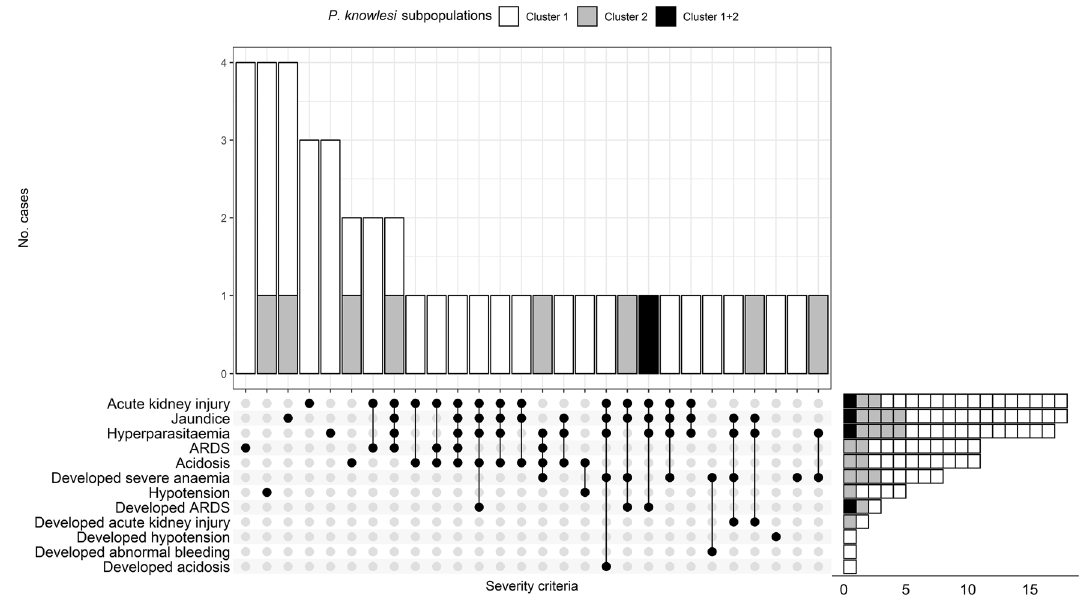
Figure 2. Combinations of severe criteria among patients infected with P. knowlesi subpopulations (N = 44). The scale on the far right x axis shows the total number of patients with each severe criteria. The y-axis of the graph shows number of patients with same combination/s of severe criteria. The criteria were : hyperparasitaemia (> 100,000 parasites/μL); severe anaemia (haemoglobin concentration < 7 g/dL); hypotension (systolic blood pressure < 80 mmHg); acute kidney injury (serum creatinine > 265 μmol/L or blood urea > 20 mmol/L); jaundice (serum total bilirubin > 50 μmol/L) with parasite count > 20,000/μL; acidosis (base deficit > 8 mEq/L or plasma bicarbonate < 15 mmol/L or venous plasma lactate ≥ 5 mmol/L); acute respiratory distress syndrome (ARDS) (respiratory rate > 30 breaths/minute plus oxygen saturation < 92% on air and/or pulmonary infiltrates on chest